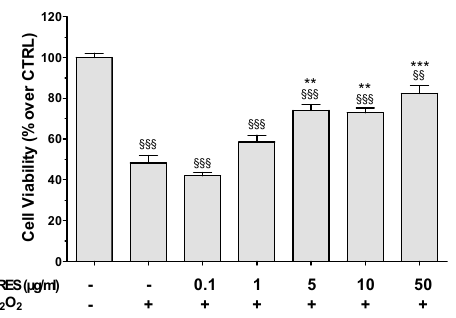
Figure 2. Effects of PRES on oxidative stress (OS)-induced cytotoxicity in SH-SY5Y cells. Cells were treated with PRES (1–50 µg/mL) for 1 h before OS and for the following 24 h. OS was reproduced by using H 2 O 2 (25 µM for 1 h + 24 h with medium). Cell viability was assessed by MTT assay and data are reported as means ± SEMs. §§ p < 0.01, §§§ p < 0.001 vs. untreated cells; ** p < 0.01, *** p < 0.001 vs. H 2 O 2 (one-way ANOVA and Bonferroni